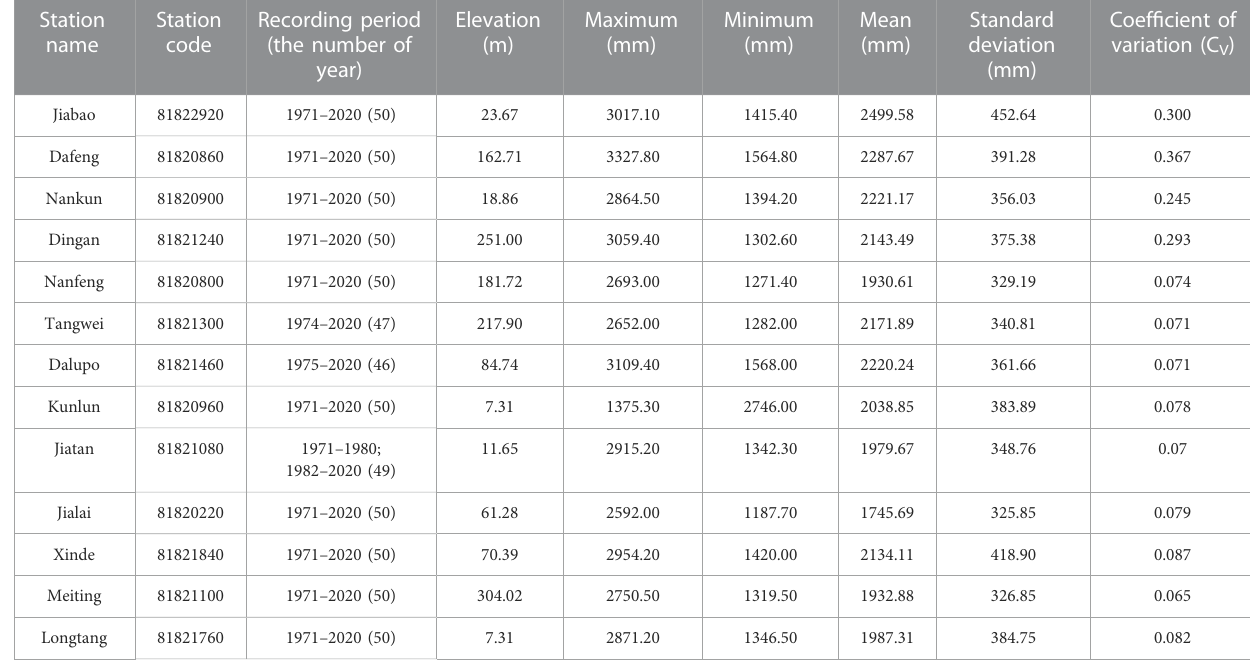
TABLE 1 Information about the weather stations and basic statistics of annual rainfall for all